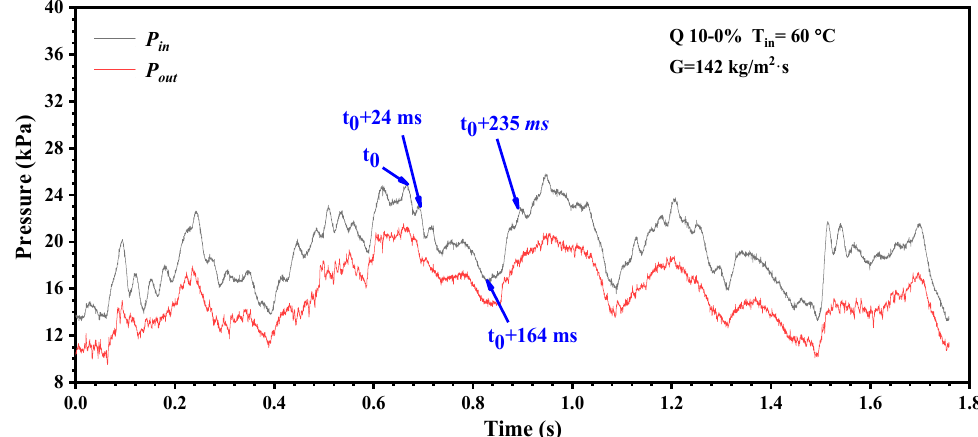
Figure 10. Pressure fluctuation curve of sample Q10-0% (q eff = 121.2 W/cm 2 ).